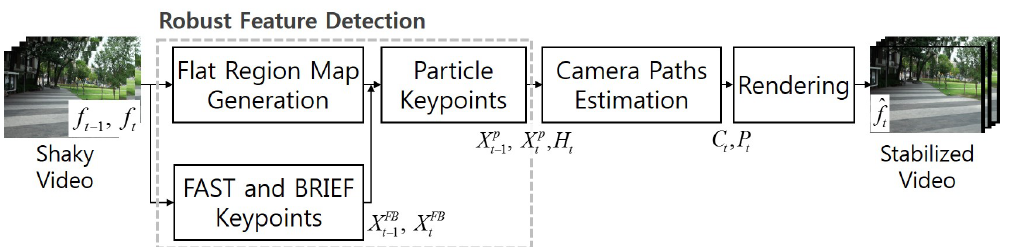
Figure 2. Block diagram of the proposed video stabilization method.